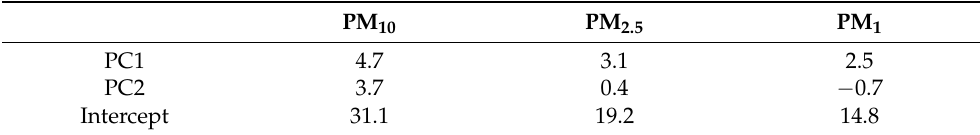
Table 2. Intercepts and coefficients for multi-linear regression of PM 10 , PM 2.5 , and PM 1 mass concen- trations during August 2007~February 2012 using the two principal components (PC1 and